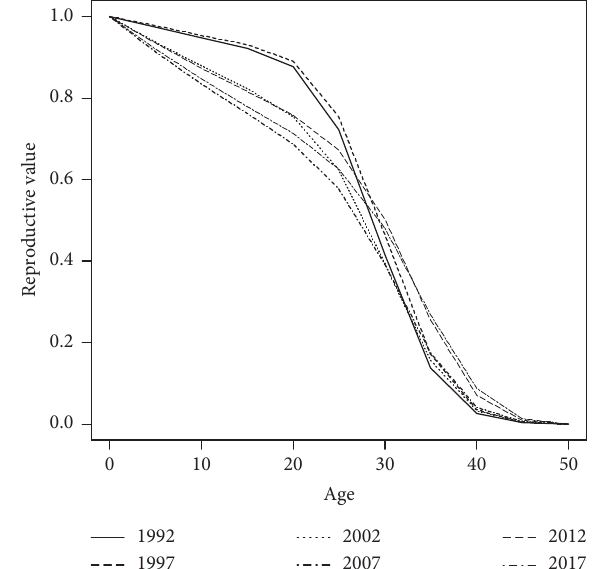
Figure 5: Age-specific reproductive values for the six